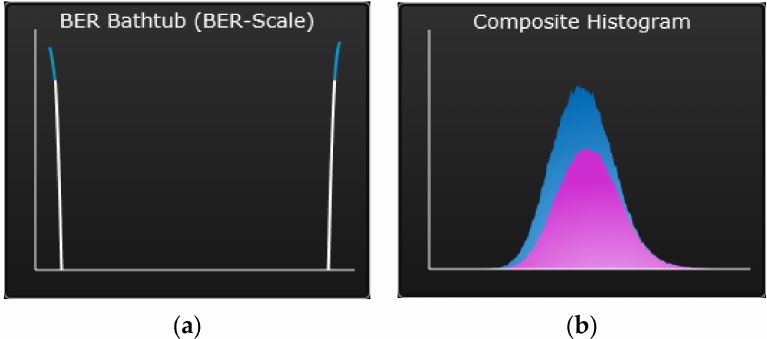
Figure 21. ( a ) Bathtub histogram (BER Tj Jitter); ( b ) Gaussian histogram (Rj Jitter). The bathtub curve slope continuity and smoothness along with Gaussian distribution profile show absence of cross talk in the measured